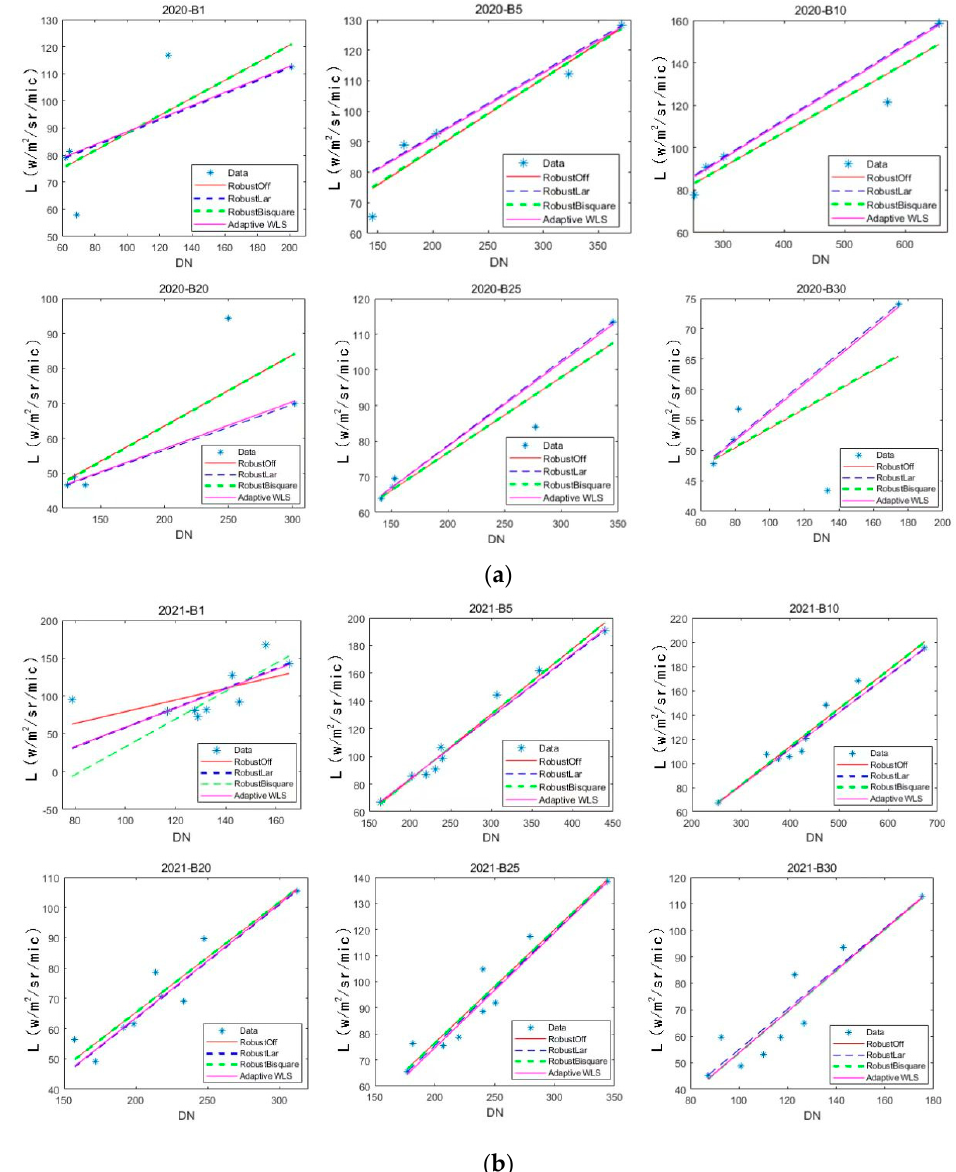
Figure 12. The radiance and DN value used to fit comprehensive gains for CMOS2. ( a ) description of 2020; ( b ) description of 2021. 2020; ( b ) description of